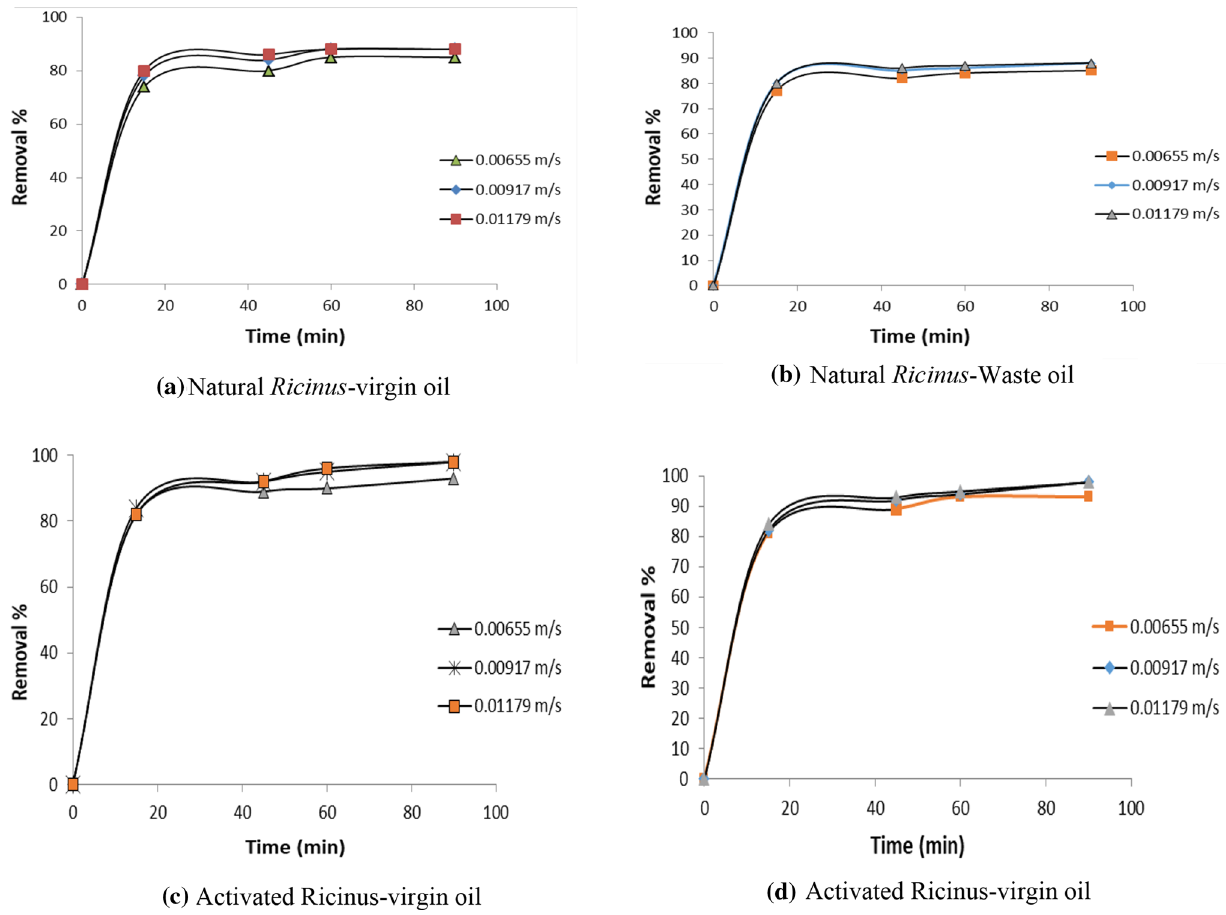
Fig. 8 Effect of liquid flow rate on the removal efficiency of oil emulsion by RC